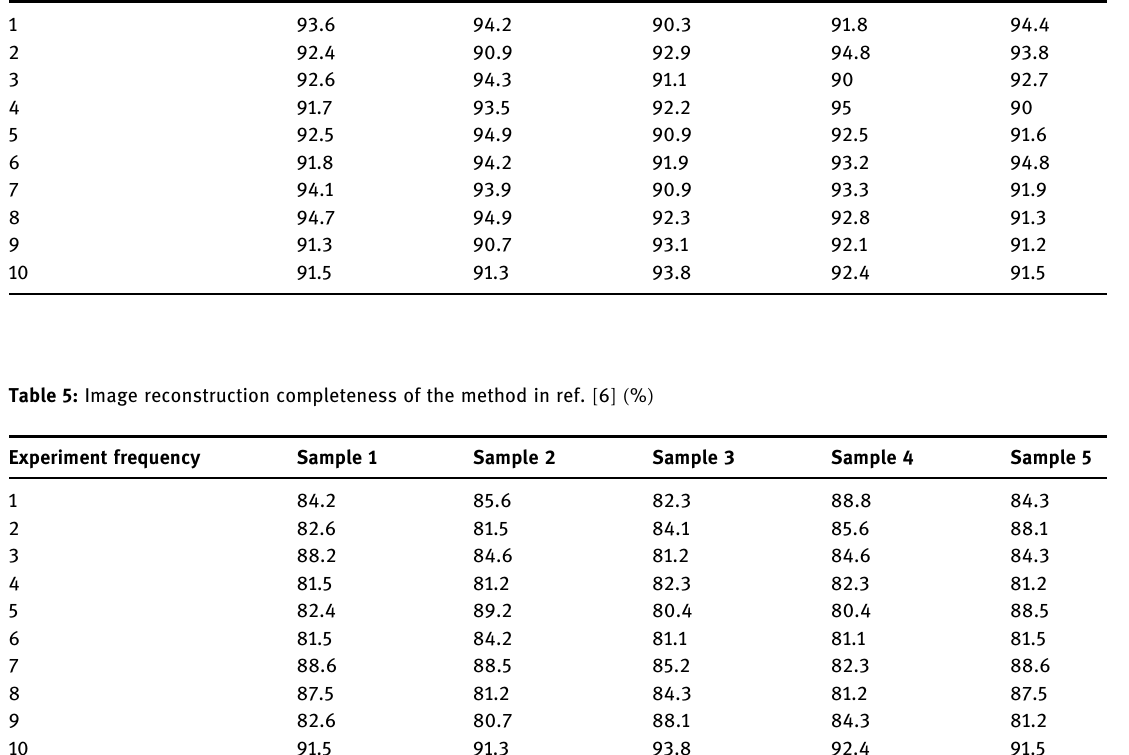
Experiment frequency